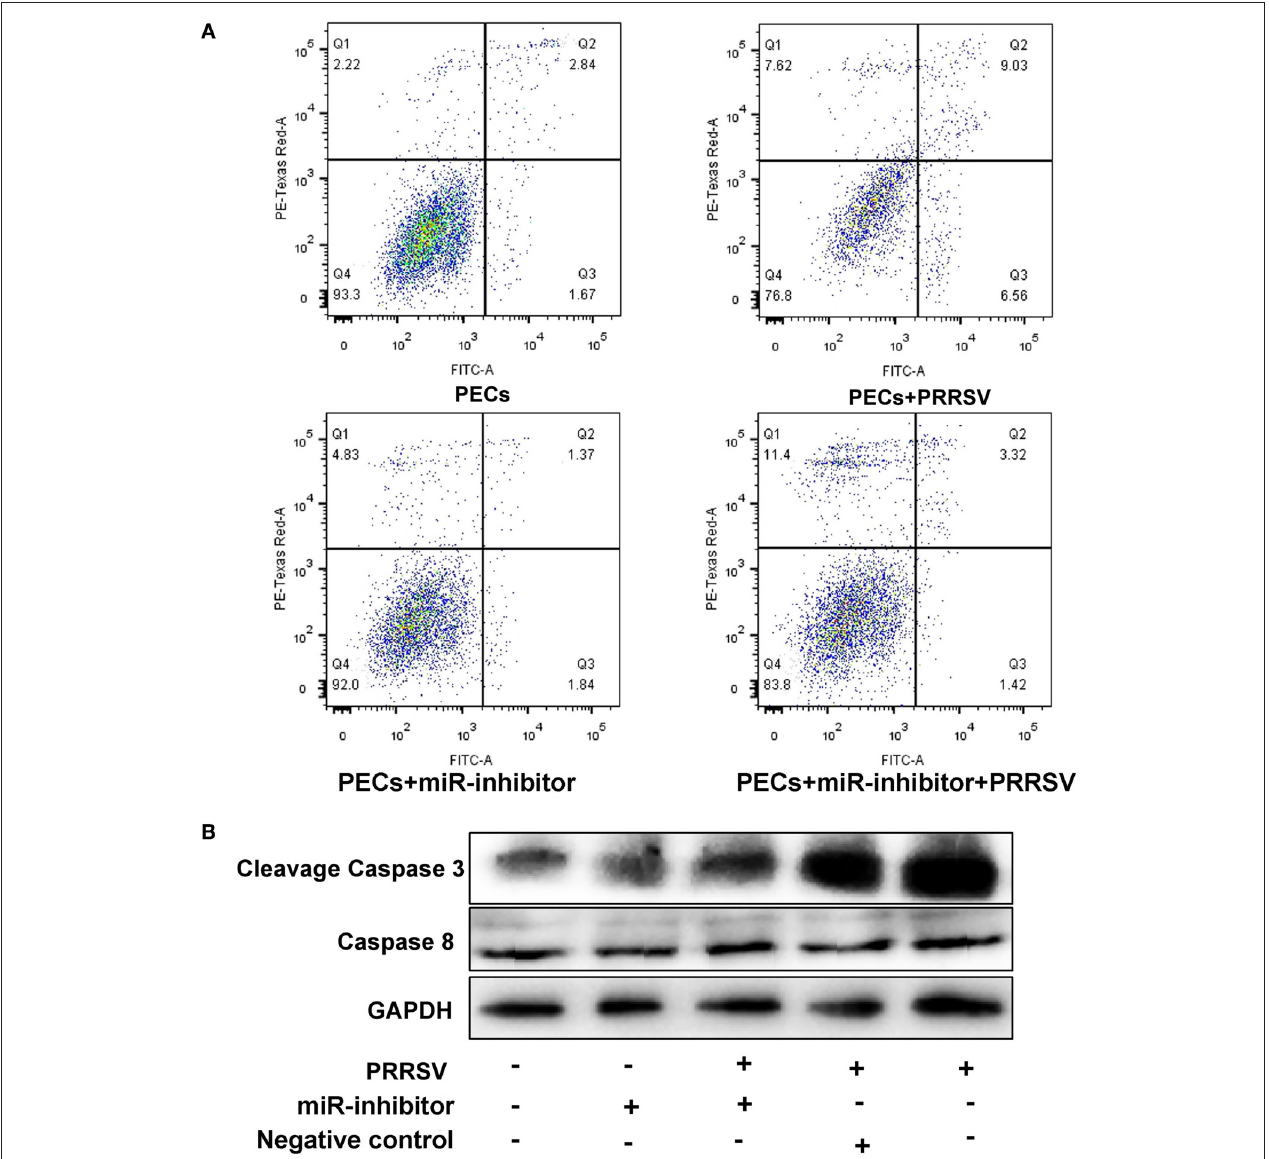
FIGURE 8 | Function analysis of miR-339-5p in PECs. (A) Apoptosis ratio analysis of PECs with different treatments. The survival ratio of cells transfected with miR-339-5p inhibitor increased compared with the normal PECs upon PRRSV infection. (B) Western blotting analysis of Caspase 3 and Caspase 8 protein. The expression of cleavage Caspase 3 protein obviously decreased after transfer miR-339-5p inhibitor, while the expression of Caspase 8 protein showed no obvious